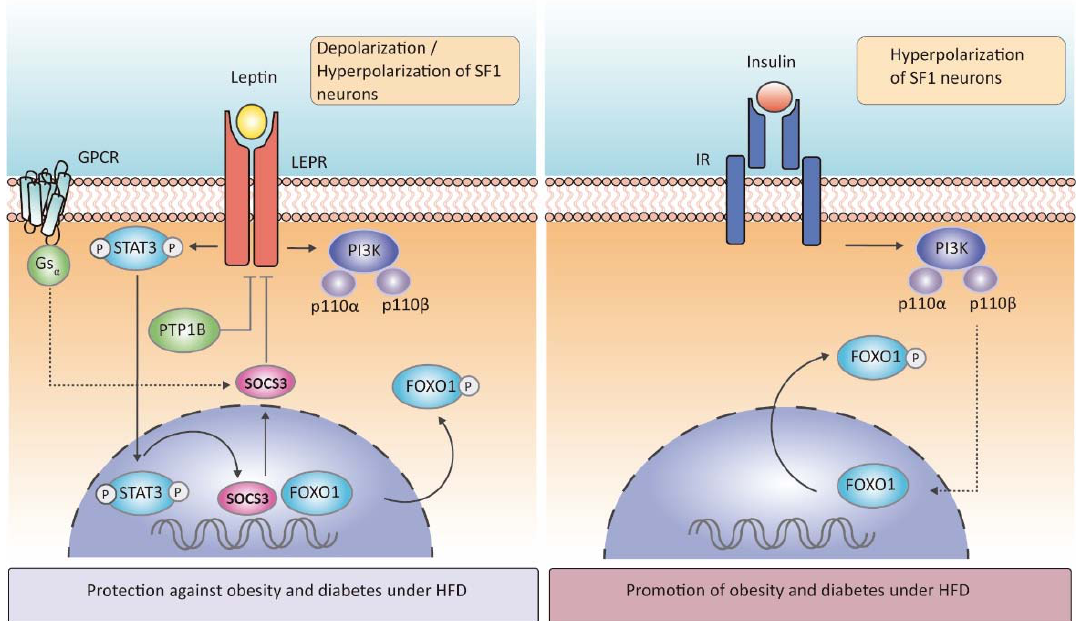
Figure 2. Leptin and insulin signaling in SF1 neurons. Leptin binds LEPR to regulate body weight gain, energy expenditure, and insulin sensitivity in the VMH via STAT3 phosphorylation which is translocated into the nucleus and induces the expression of genes such as SOCS3, a negative regulator of LEPR. Leptin also stimulates a PI3K-dependent pathway, particularly involving subunits p110 α , which contributes to energy expenditure regulation, and p110 β , which contributes to both brown fat thermogenesis and glucose metabolism regulation in SF1 neurons. The Gs α subunit of G protein-coupled receptors (GPCR) of hormones and the protein-tyrosine phosphatase 1B (PTP1B) negatively regulates leptin action. The activation of this leptin signaling pathway triggers protection against obesity and diabetes under a high-fat diet (HFD) feeding. According to insulin signaling in SF1 neurons, exposure to HFD drives hyperinsulinemia, insulin binds insulin receptor (IR), which in turn activates PI3K that indirectly phosphorylates FOXO1 to induce transcription factors and promote obesity and glucose metabolism disruption.